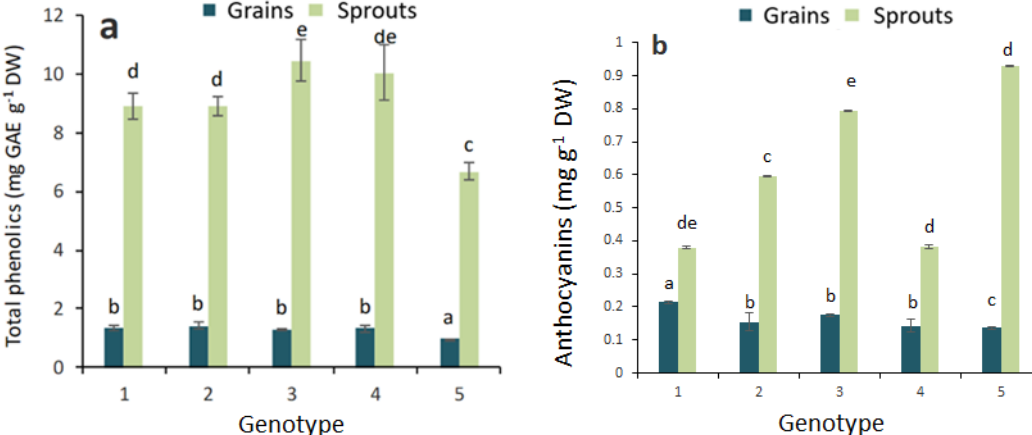
Figure 2. Total phenolics ( a ) and total anthocyanins ( b ) in the grains and sprouts of colored wheat genotypes. 1—Citrus yellow, 2—KM 53-14 Blue, 3—KM 178-14 purple, 4—Skorpion Blue aleurone, 5—PS Karkulka purple. The columns represent the mean values ± S.E. for five replicates. Statistically significant differences among treatments at each time are indicated by different lowercase letters (Duncan test; p < 0.05).